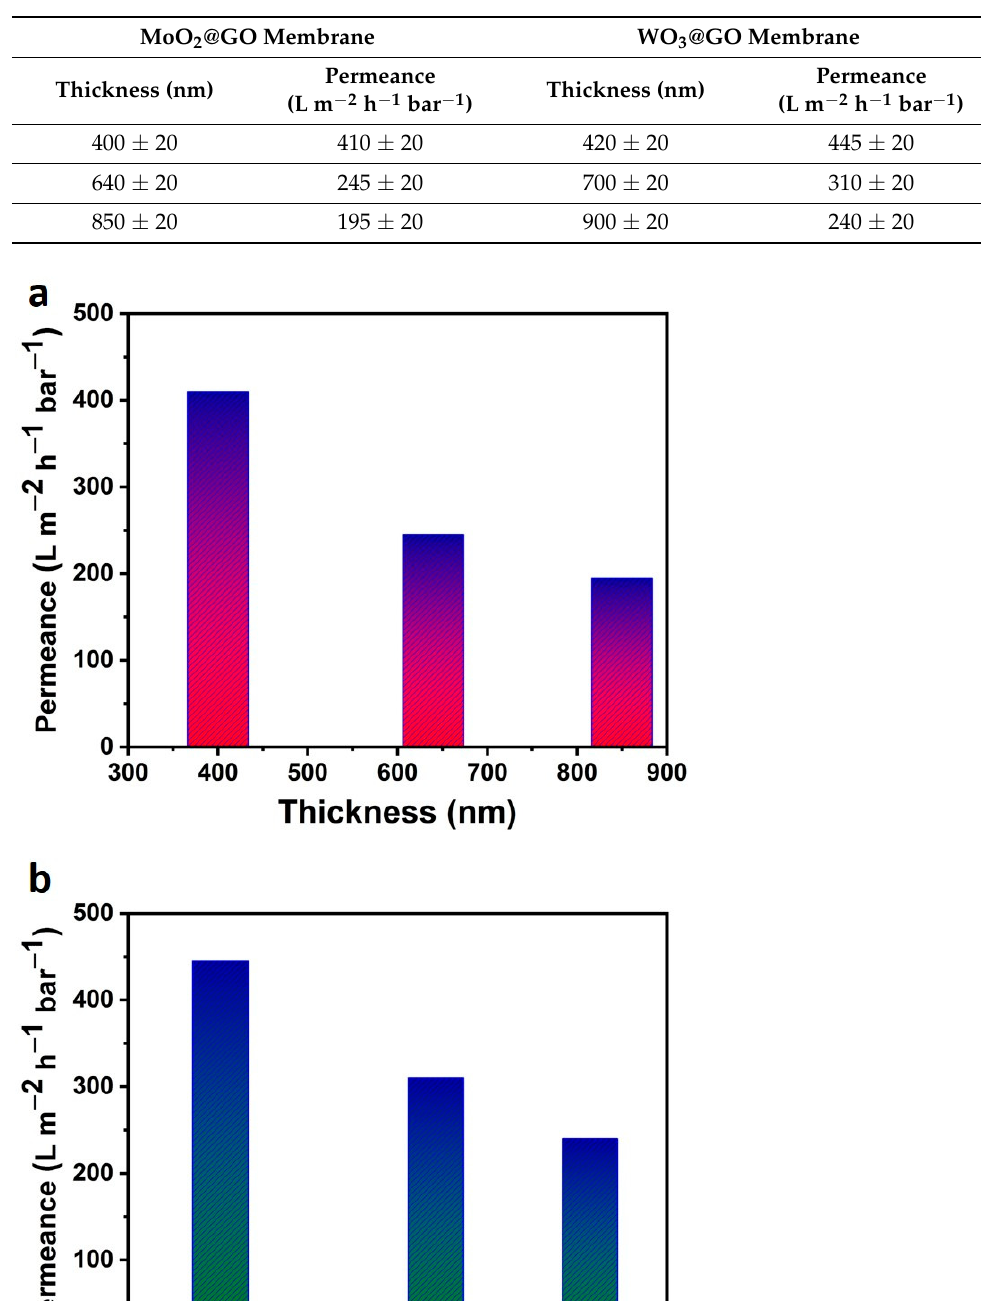
Table 1. The water permeance of MoO 2 @GO and WO 3 @GO-based composite membranes with various thicknesses.